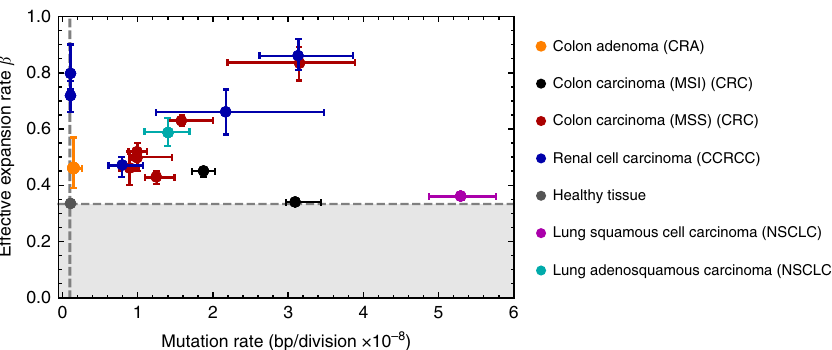
Fig. 6 Map of per-cell mutation and per-cell survival rates across cancer types. For each of the 16 tumours analysed we plot the per-cell mutation rate versus the per-cell survival rate. Median estimates and 95% credibility intervals for the mutation and cell survival rate are derived from the MCMC inferences as described in the main text. Dashed lines correspond to values of healthy tissue ( μ h = 1 × 10 − 9 , β h = 1/3). White background corresponds to β values that allow for growing cell populations as β = 1/3 corresponds to stable (homeostatic) populations. Shaded area describes values of β that would lead to population extinction. Most cancers scatter across the map, indicating extensive